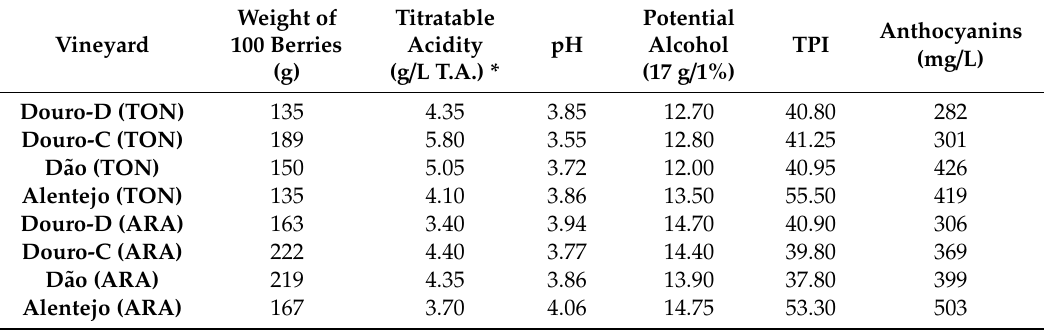
Table 3. Characterization of the selected berry quality parameters. The values represent the average of each berry quality parameter. TON—Touriga Nacional; ARA—Aragonez; * g of tartaric acid equivalents per L of